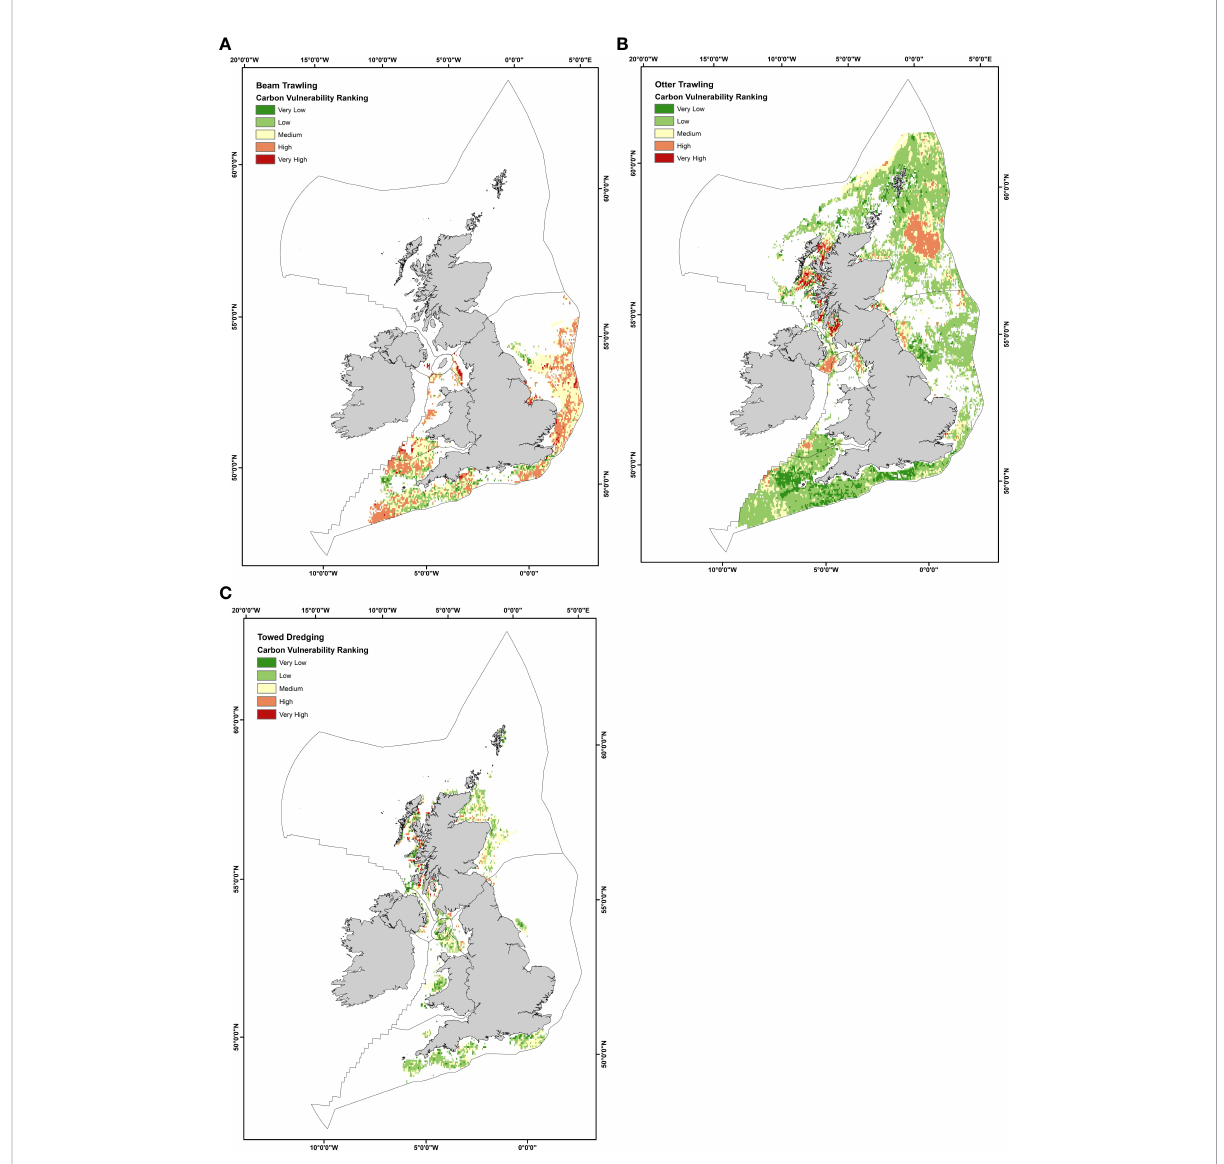
FIGURE 6 Carbon vulnerability ranking (CVR) by fi shery type. All three fi shing types are associated with regional hot spots where the CVR is very high. These hotspot areas typically coincide with muddy sediment types where labile organic matter content is high; a high swept area ratio also characterises these inshore fi shing areas. (A) Beam Trawling, (B) Otter Trawling, (C) Towed